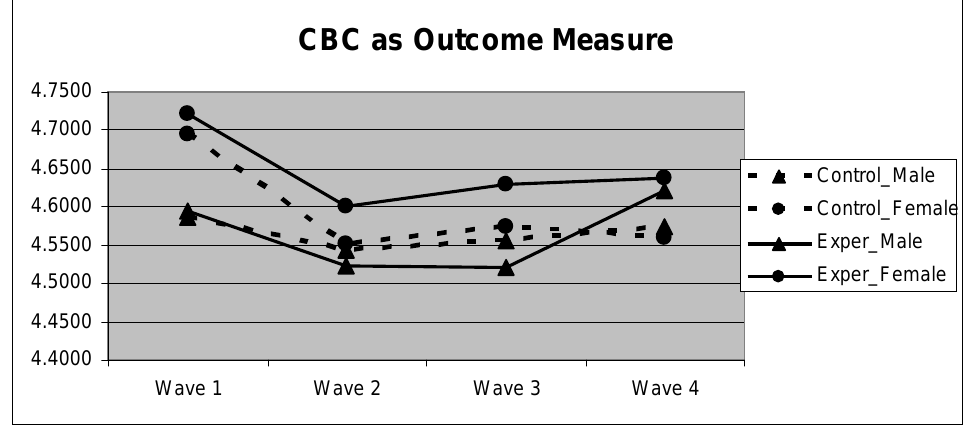
FIGURE 2. Growth trajectories in the experimental participants participating in the Tier 1 Program and control participants using CBC as an outcome indicator.